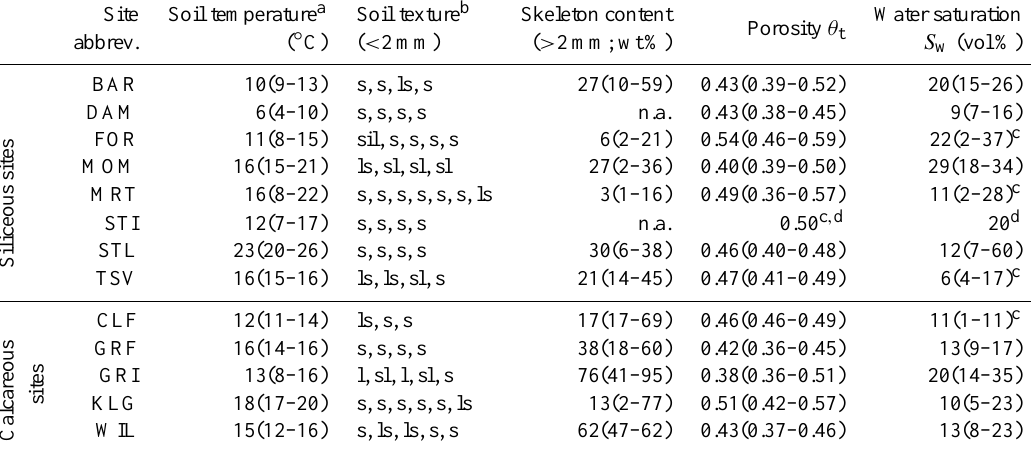
Table 2. Overview of physical properties at sampled sites in 0–10cm soil depth. Soil texture is reported in sequence of sampled locations; for soil temperature, skeleton content, θ t and S w , we reported the the median with the range of measured values in parentheses. Note that the median should be interpreted with care for sites with a small number of sampled locations (see Table 1).